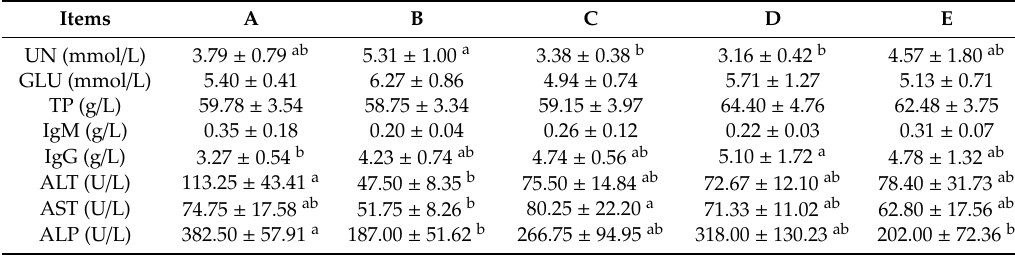
Table 4. E ff ect of CPB on serum indexes of piglets.